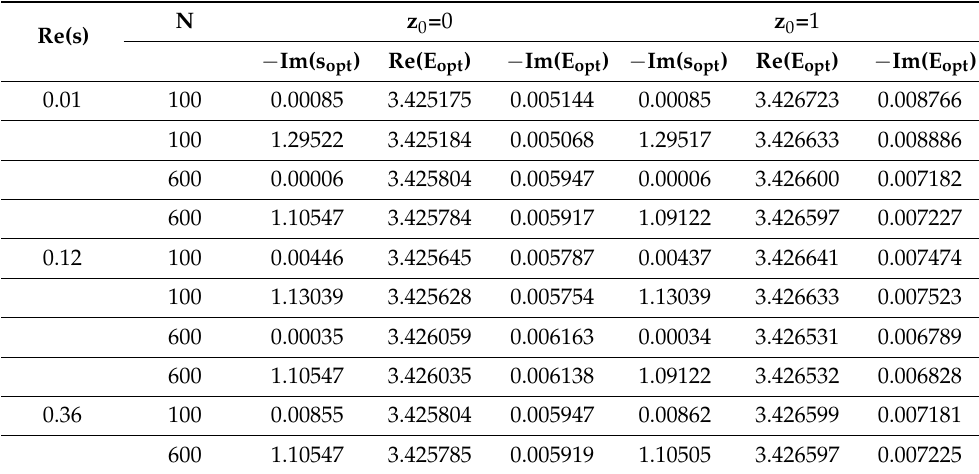
Table 3. Optimal trajectory points (problem III). All the data are presented in a.u.